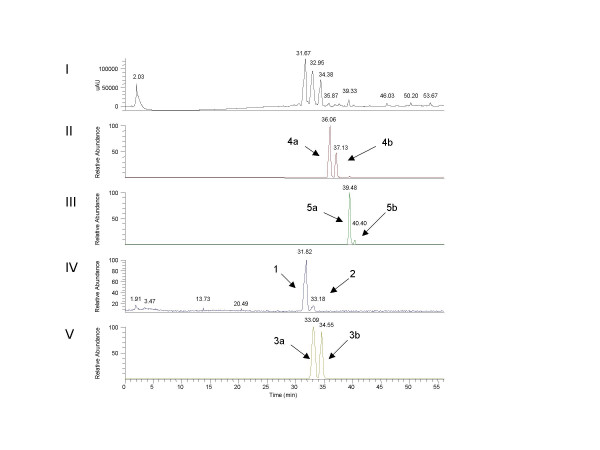
LC-UV-MS and LC-UV-MS/MS spectra of Ukrain. I: LC-UV (290 nm) chromatogram; II: LC-MS/MS ion chromatogram of m/z 332.1; III: LC-MS/MS ion chromatogram of m/z 348.4; IV: LC-MS/MS ion chromatogram of m/z 354.1; V: LC-MS/MS ion chromatogram of m/z 370.2.